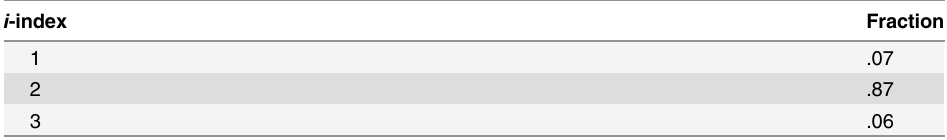
Table 4. The i -index for the hit games.